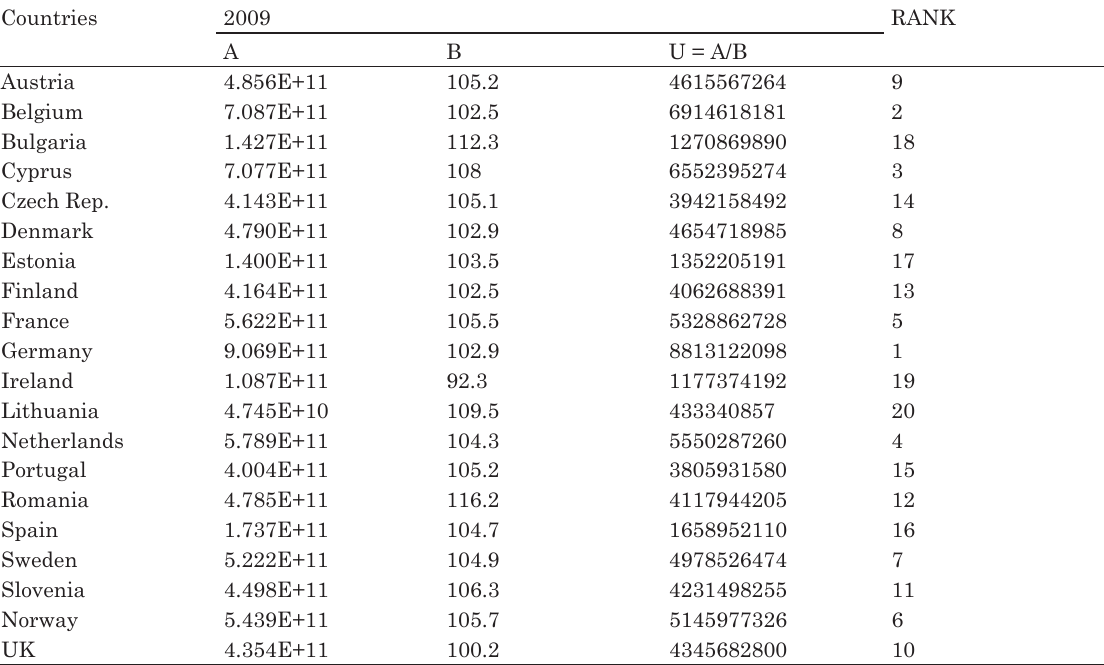
Table A2b. The full multiplicative form and ranks of states, 2009 Countries